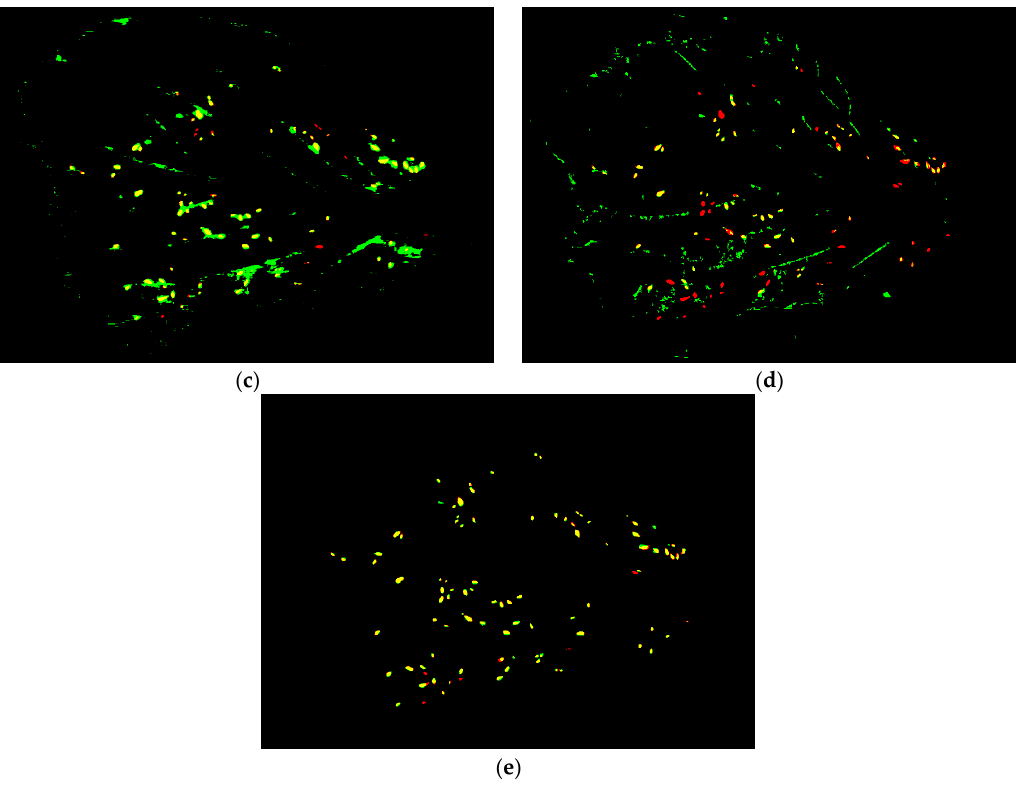
Figure 3. Segmentation results of a test image by three methods. ( a ) The original image; ( b ) manual annotation; ( c ) segmentation by method 1; ( d ) segmentation by method 2; ( e ) segmentation by the proposed method.